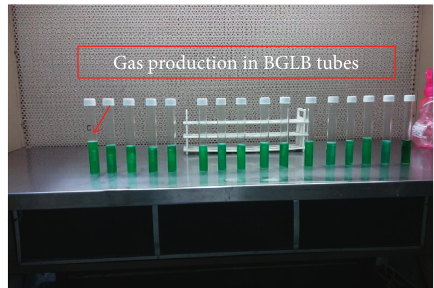
Figure 2: Growth of total coliform in BGLB tubes showing gas production in Durham’s tubes.